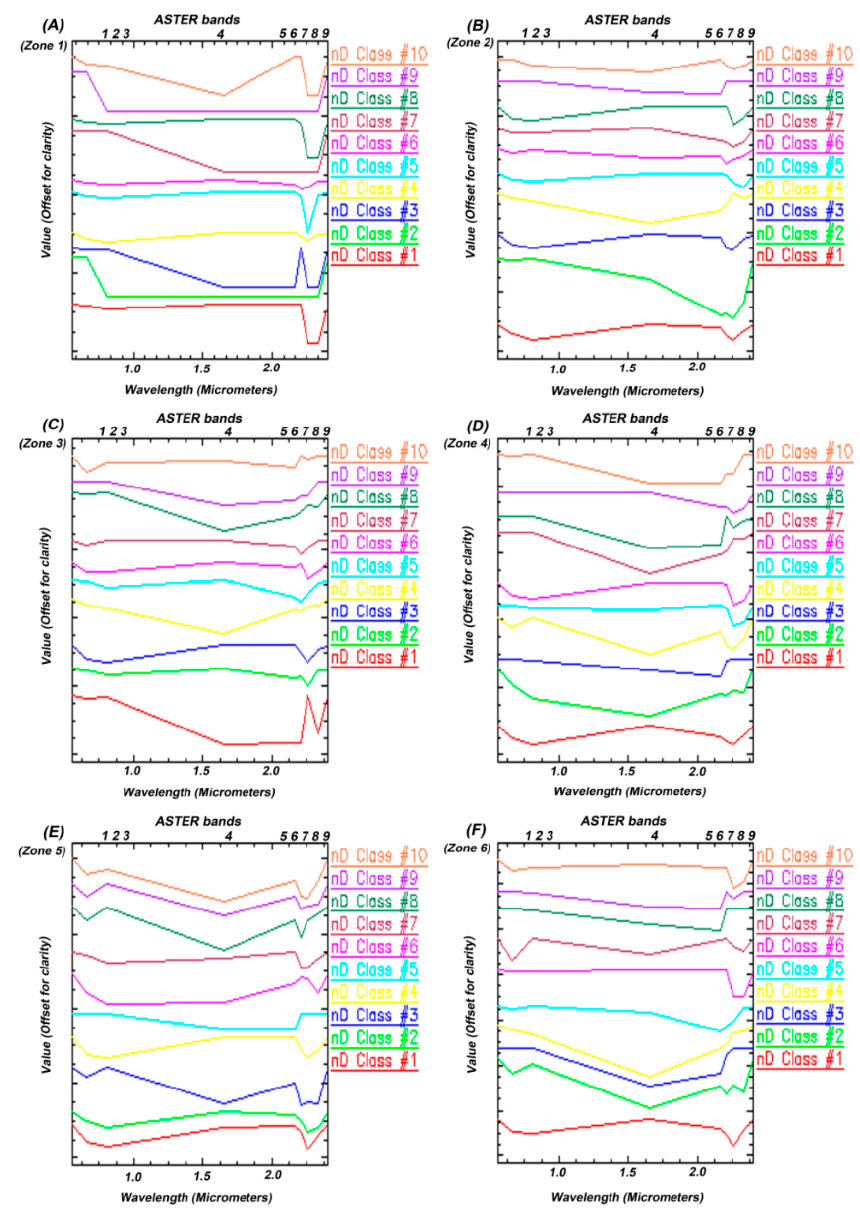
Figure 9. End-member (mean) spectra extracted from ASTER VINR + SWIR bands using the n-Dimensional analysis technique for the six selected subsets of the damage (fault) zones. ( A ) Zone 1; ( B ) Zone 2; ( C ) Zone 3; ( D ) Zone 4; ( E ) Zone 5; and ( F ) Zone 6. ASTER band center positions are shown for the selected zones.